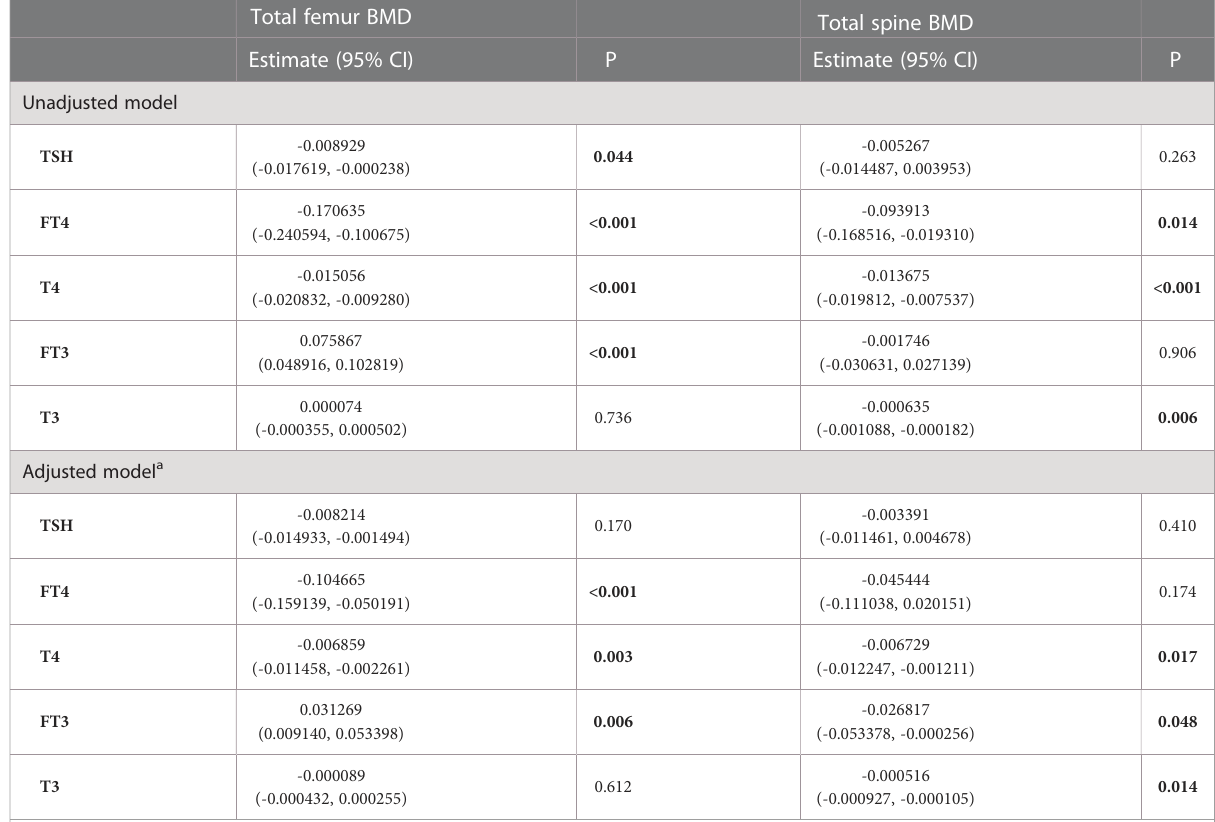
TABLE 6 Association of the thyroid hormone pro fi le with BMD in participants aged >50 years.